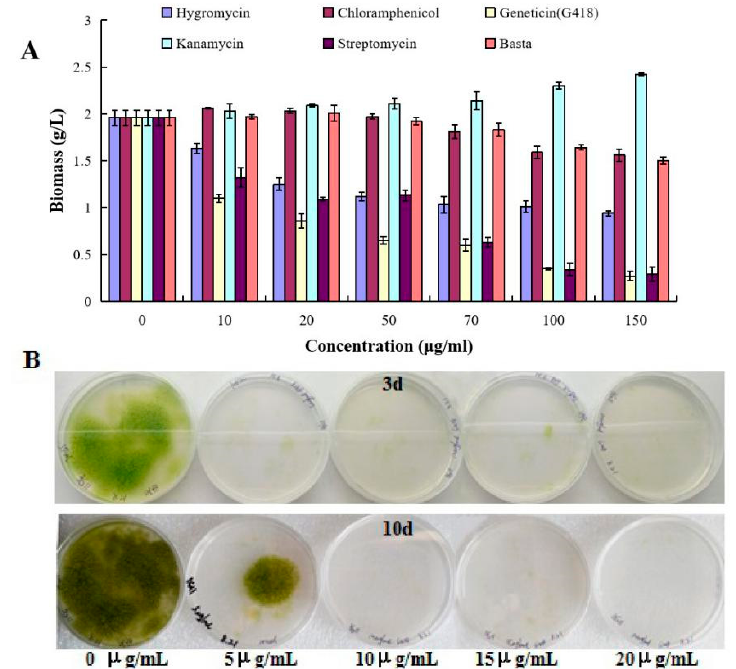
Figure 1. Analysis of herbicide and antibiotic sensitivities of T. minus . ( A ) Effects of different concentrations of all tested herbicides and antibiotics on the growth of T. minus in liquid medium. Five different antibiotics and one herbicide were used in this experiment, including hygromycin (light purple bars), chloramphenicol (dark red bars), geneticin (light yellow bars), kanamycin (light blue bars), streptomycin (dark purple bars), and basta (light red bars). Data are the average of n = 3 independent repeats; bars show SDs. Significant differences in biomass changes under each antibiotic test ( p ≤ 0.05). ( B ) Growth of T. minus on the agar plates containing different concentrations of G418.